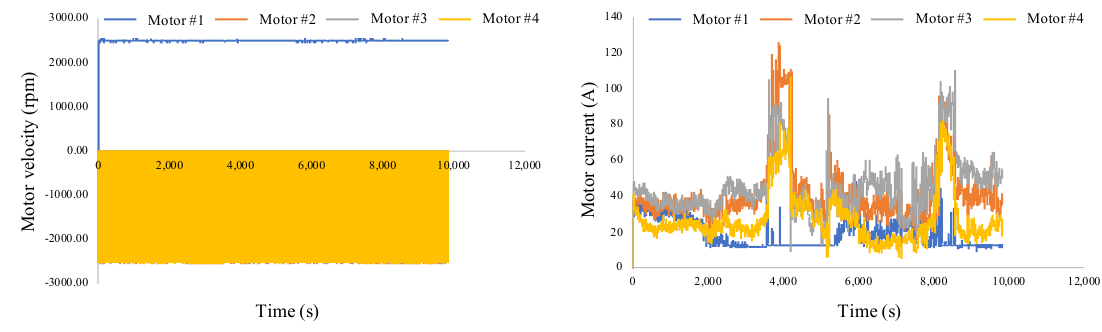
Figure 15. Testing results at the Heihe Pipeline Construction Site.